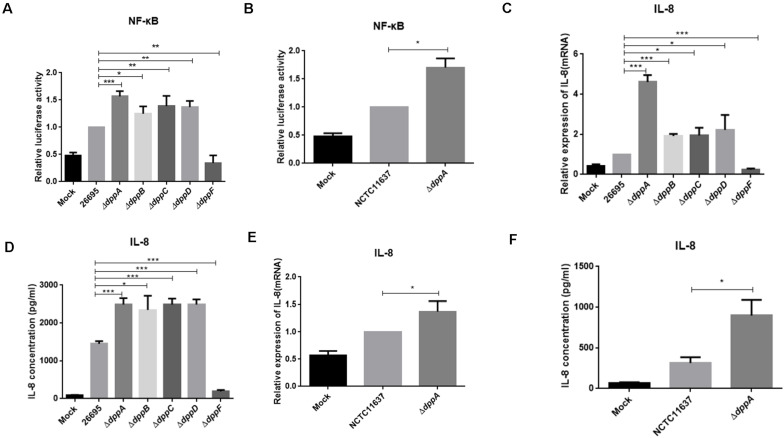
NF-κB activation and IL-8 production induced by H. pylori and Dpp transporter mutant strains. (A) NF-κB activity determined by luciferase activity of NF-κB-luc. AGS cells were transfected with a NF-κB luciferase reporter and were infected with H. pylori 26695, ΔdppA, ΔdppB, ΔdppC, ΔdppD, or ΔdppF, as well as being infected with H. pylori NCTC11637 and its isogenic mutant ΔdppA
(B). Relative luciferase activity represents luciferase activity normalized to mock samples. (C,E) Expression of IL-8 in AGS cells as determined by qPCR or by ELISA (D,F). AGS cells were infected with H. pylori 26,695 and its isogenic Dpp transporter mutant strains, or H. pylori NCTC11637 and ΔdppA for 4 h with an MOI of 100. Data represent averages normalized to mock controls and are shown as the mean ± SD (n = 3). ***P < 0.001, **P < 0.01, *P < 0.05.